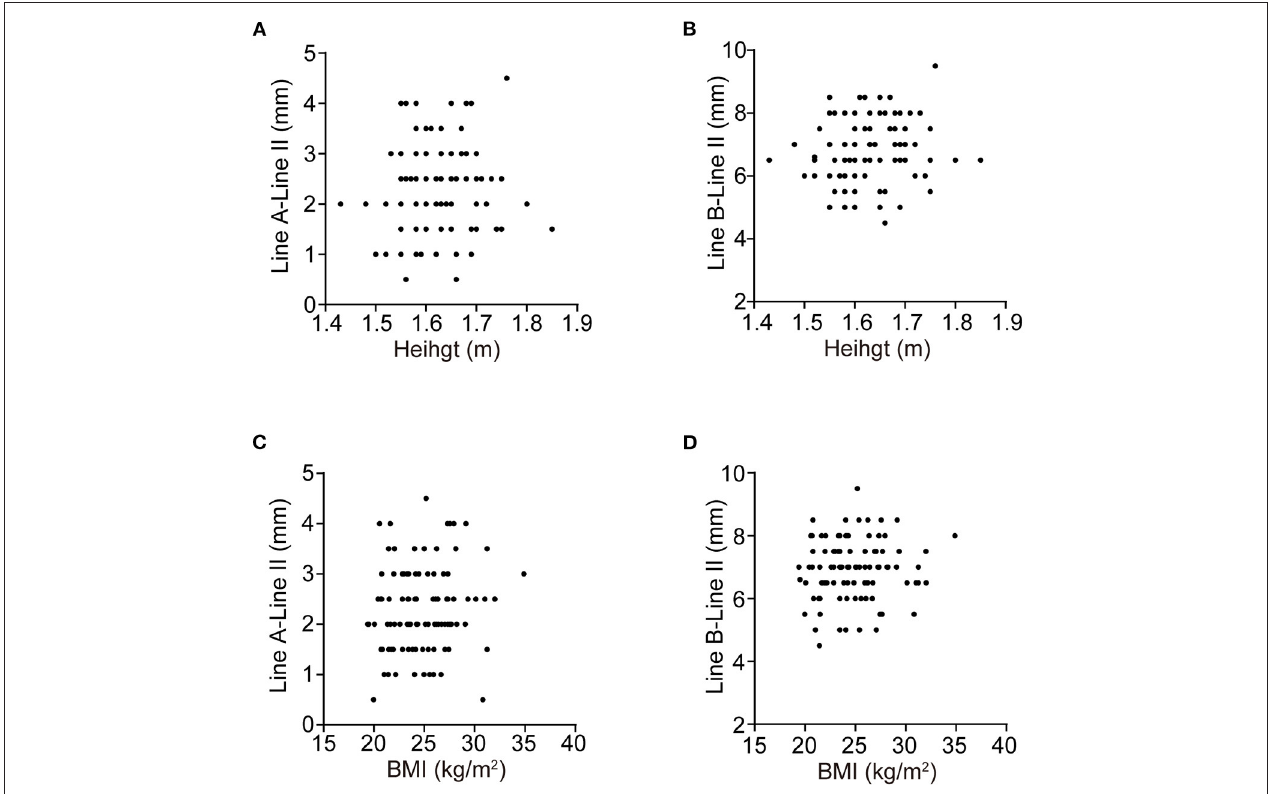
FIGURE 4 | The scatter diagrams. (A–D) are the scatter diagrams of the distances between the cephalic, caudal end of the CN IX-X REZ, and the pontomedullary sulcus and the height, BMI, respectively. No monotonic relationship is found.